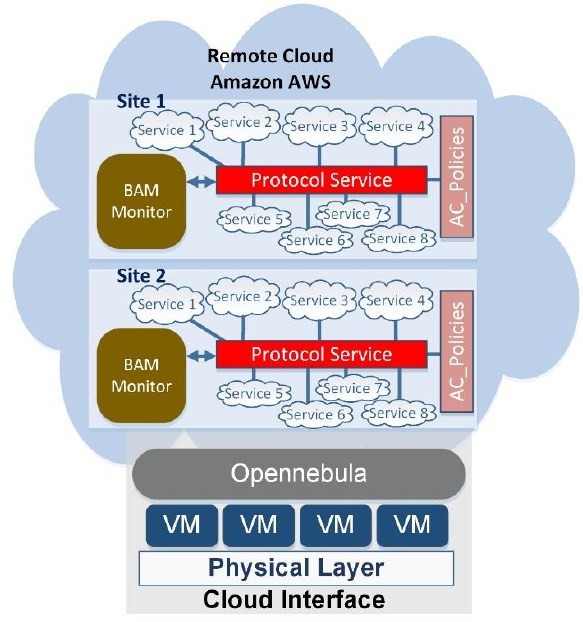
Fig. 6. An overview of the